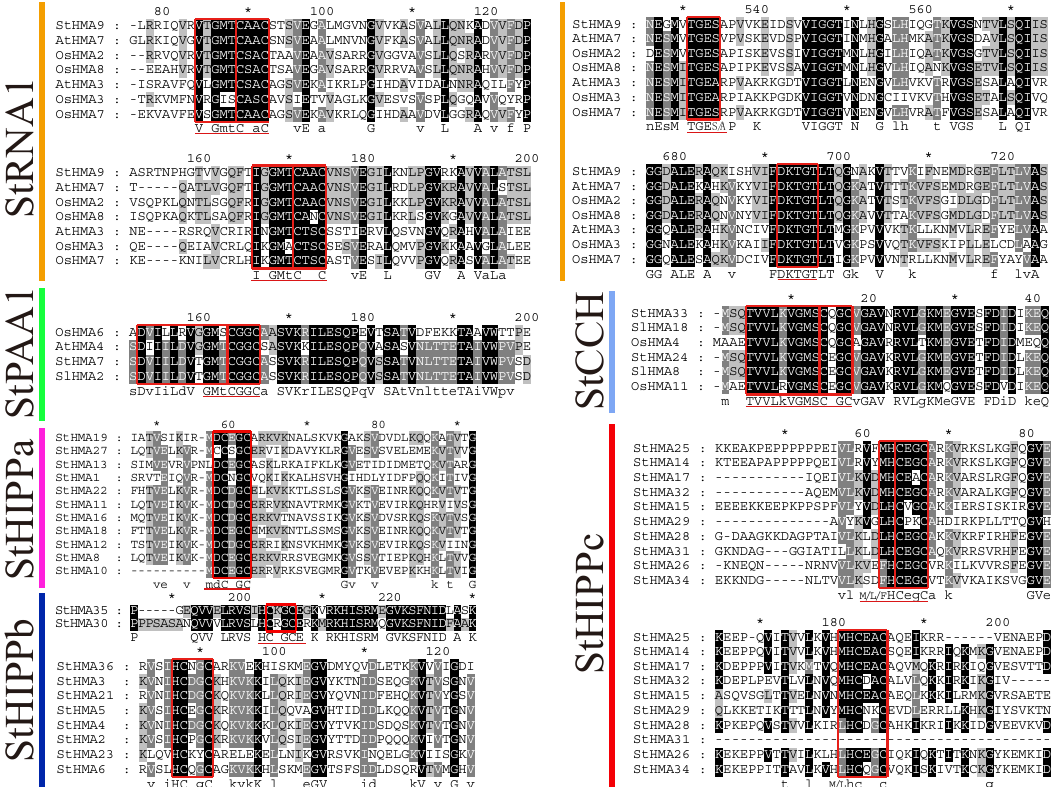
Figure 5. Multiple Alignment of StHMAs Metal binding domains amino acid sequences. “StRNA1”, “StPAA1”, “StCCH”, “StHIPPa”, “StHIPPb”, and “StHIPPc” represent di ff erent StHMA proteins classification. The putative xxCxxC, TGEx, and DKTGT motifs locations were highlighted in red boxes. Comparison of MBD motifs in Solanum tuberosum , Arabidopsis thaliana , Oryza sativa and Solanum lycopersicum HMA proteins.